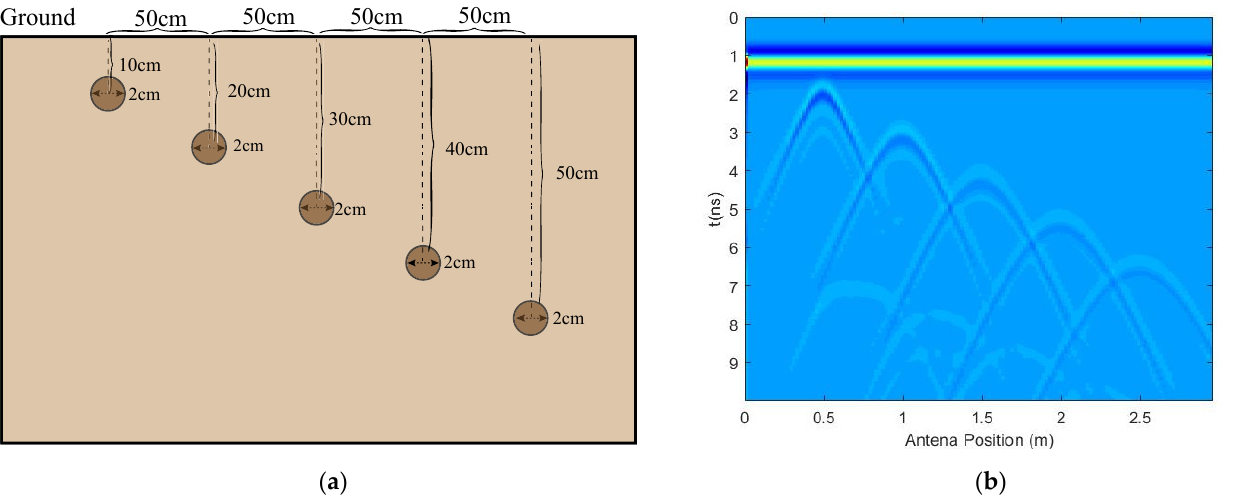
Figure 11. YOLOv5s results: ( a ) YOLOv5s detection results; ( b ) change curve of the evaluation index of using the YOLOv5s model.